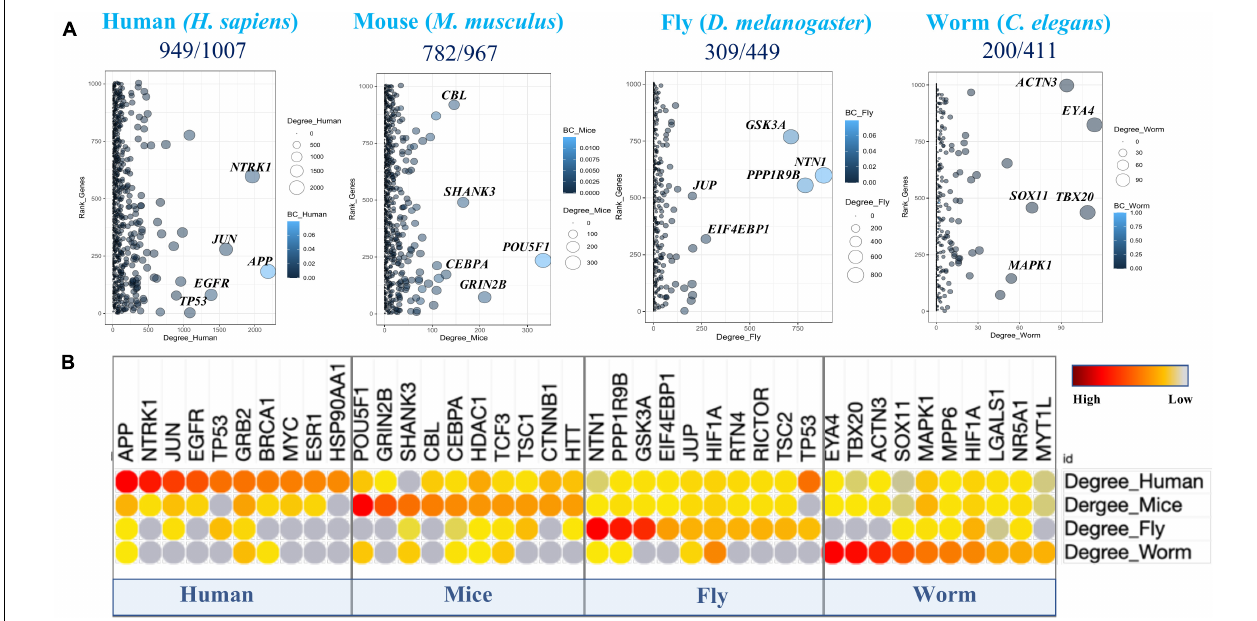
FIGURE 2 | Cross-species PPIN topologies comparison. (A) The degree (connecting topology) distribution of aging and longevity related genes (Human) and their orthologs (mice, flies, and worms) in corresponding protein interactomes. The Y axis provides the ranking order based on the Convergent Evidence Score (CES) of the 1007 genes. The node size and color indicate the number of degree and betweenness centrality (BC) values respectively for each gene in the corresponding PPIN. (B) Top ten highly connected human aging and longevity related genes (hubs) in the protein interactome of each species and their corresponding orthologs in other species are